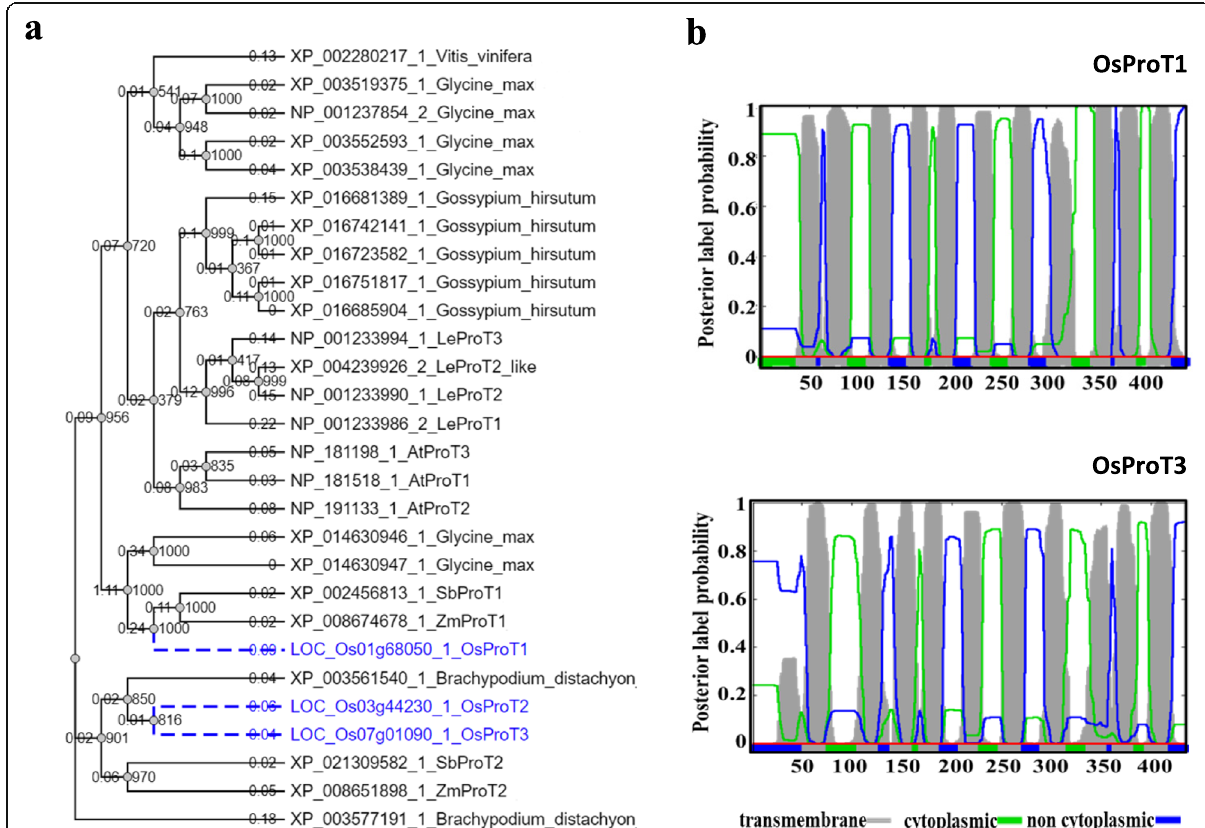
Fig. 1 Phylogenetic analysis and prediction of transmembrane helices for OsProT1 and OsProT3 . a Phylogenetic analysis of ProT protein sequences from Oryza sativa (Os), Zea mays (Zm), Sorghum bicolor (Sb), Arabidopsis thaliana (At), Lycopersicon esculentum (Le), Brachypodium distachyon, Vitis vinifera, Glycine max and Gossypium hirsutum. Dendrogram was generated by NGPhylogeny.fr (https://ngphylogeny.fr.) with 1000 bootstrap replications using the default parameters. Values at each tree root indicate bootstrap values and values on each branch indicate branch lengths. b Transmembrane prediction of OsProT1 and ProT3 using Phobius